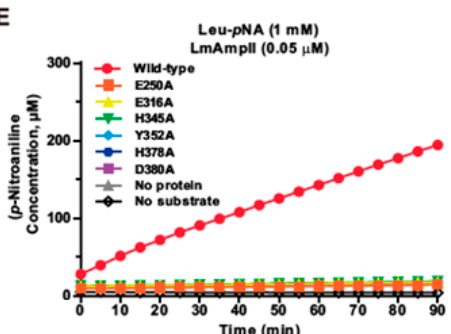
Figure 1. The cytoplasmic putative aminopeptidase II (LmAmpII) is an active aminopeptidase II of the M29 family with a wide range of substrate specificities. ( A ) Localization of LmAmpII in L. monocytogenes . Proteins were separated through a 12% SDS-PAGE and immunoblotted with α - LmAmpII, α -InlB, α -LLO, or α -GAPDH antisera. The predicted molecular weight of each protein is indicated on the left. ( B ) SDS-PAGE analysis of the recombinant LmAmpII and its mutant variants with single site-directed mutagenesis at the predicted active sites. ( C , D ) Enzymatic activity of LmAmpII using Lys-, Arg-, Asp-, Asn-, Ser-, Gly-, Leu-, Phe-, Val-, or Ala- p NA and polypeptides Gly-Pro-, Ala-Ala-Pro-Phe-, D-Phe-Pip-Arg-, or Val-Gly-Gly- p NA as substrate at a concentration of 1 mM in 25 mM Tris-HCl (pH 7.4) bu ff er. ( E ) Aminopeptidase activity of the wild-type LmAmpII and its mutant variants (E250A, E316A, H345A, Y352A, H378A, and D380A) using Leu- p NA as a substrate in 25 mM Tris-HCl (pH 7.4) bu ff er. Data shown represent mean ± SD.